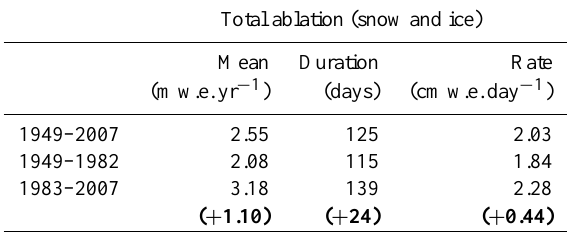
Table 4. Amount, duration and rate for indistinct snow and ice ab- lations at Sarennes over the whole period of record and before and after the breakpoint identified by the analysis of variance. Bold face values are variations after the 1982 breakpoint identified in the sum- mer balance time